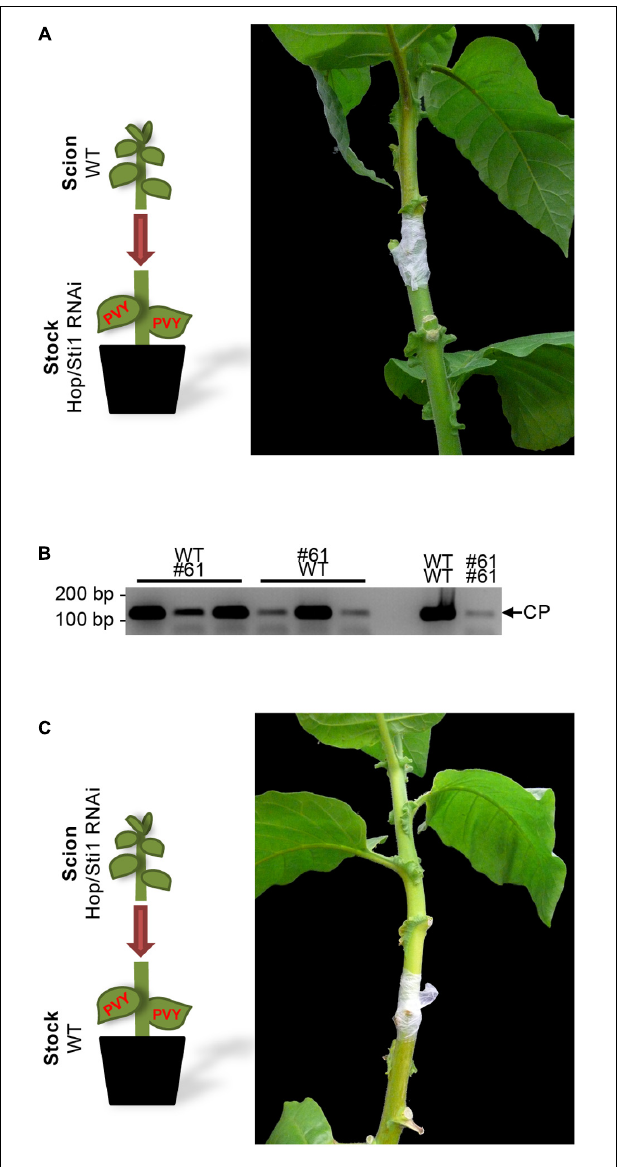
FIGURE 7 | Reciprocal grafting of wild-type and Hop/Sti1-RNAi plants. (A) A wild-type scion was grafted on a PVY N -infected Hop/Sti1-RNAi rootstock. Two weeks after grafting, the wild-type type scion displayed infection symptoms. (B) Accumulation of viral RNA in scions of grafted wild-type and Hop/Sti1-RNAi plants, samples taken 2 weeks after grafting. RT-PCR was used to amplify a 122-basepair fragment of the viral RNA encoding the coat protein (depicted by an arrow labeled CP). Grafting combinations are labeled as scion over infected rootstock. Viral RNA could be detected in all tested mixed grafts (left) as well as in control plants (right, wild-type scion on infected wild-type rootstock, analogous for transgenic line #61). (C) Hop/Sti1-RNAi scion grafted on infected wild-type rootstock. Two weeks after grafting, the transgenic scion was still symptom-free, although viral RNA was detectable (compare to B